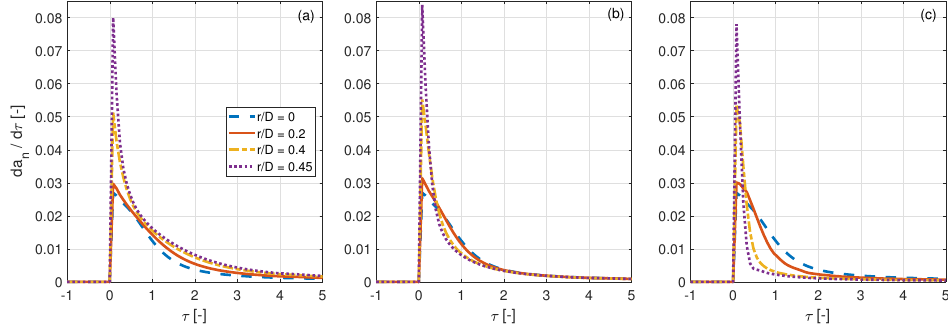
Figure 12. Time derivative of a n at different radial positions from CFD model when base C T = 0.6, step ∆ C T = +0.1, r/D = 0.4, ( a ) downwind part: θ az = 0 deg, ( b ) center part: θ az = 90 deg, ( c ) upwind part: θ az = 180